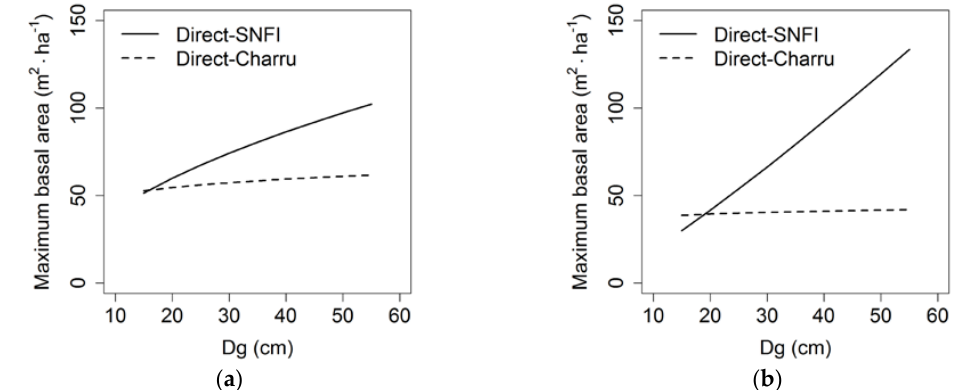
Figure 2. Maximum basal area over quadratic mean diameter derived using two Direct alternatives: ( a ) for Norway spruce; ( b ) for European beech. The “SNFI” parameters were estimated using data of the Swiss National Forest Inventory (SNFI). The “Charru” parameters stem from Charru et al. [43]. Dg : quadratic mean diameter (cm).